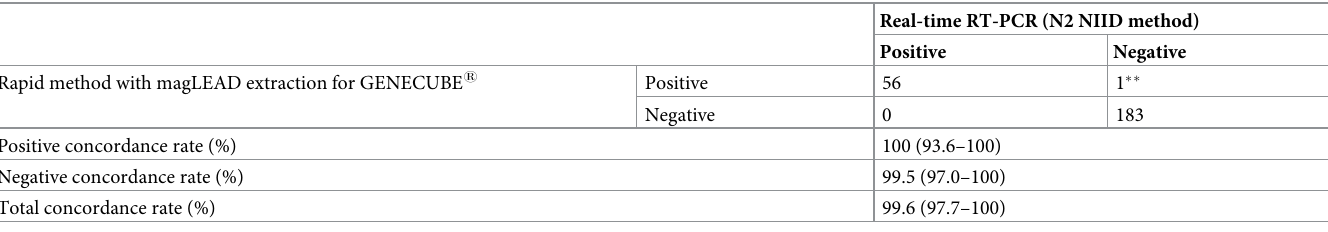
Table 7. Concordance rate of the standard method with magLEAD extraction for GENECUBE 1 with real-time RT-PCR for saliva samples � .